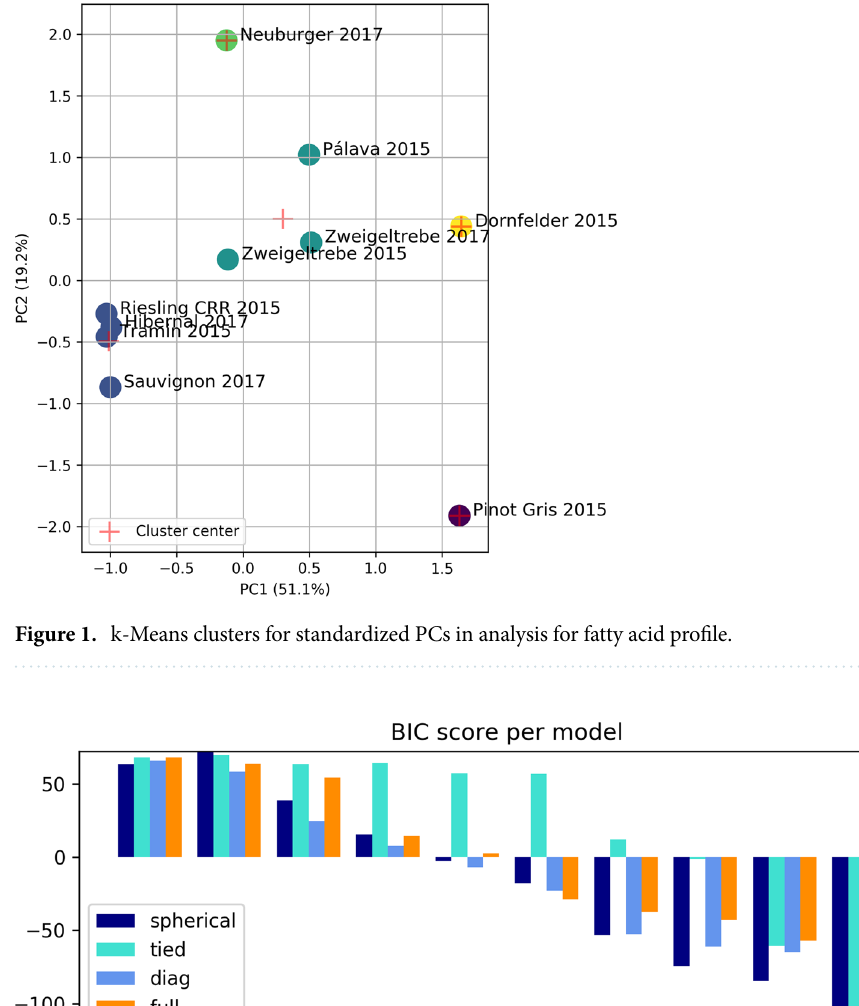
Fig. 4. The cultivars selected for the FTIR study included: Dornfelder 2015, Hibernal 2017, Neuburger 2017, Pálava 2015, Pinot Gris 2015, Riesling 2015, Sauvignon 2017, Tramin 2015, Zweigeltrebe 2015, and Zweigeltrebe 2017. For better convenience of analysis, discussion, and comparison of the respective samples studied, the spectra were normalized at the maximum of 1745/cm. The samples were placed on a ZnSe crystal and studied